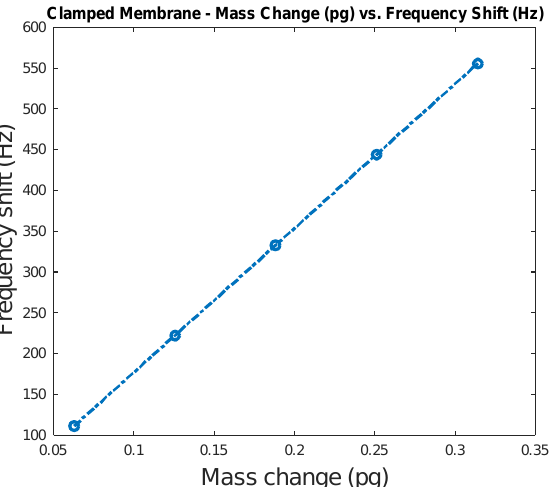
Figure 19. Sensitivity analysis for a silicon capacitive clamped membrane sensor when the target adsorbed mass is increased from 0.25 to 0.63 pg with a step size of 0.063 pg. The investigated sensor has a 40 μm diameter, when the thickness of the top and bottom membranes and the cavity height are 0.5 μm each. A bias of 20 V DC, which is chosen close to the device’s pull-in voltage, is applied to the capacitive clamped membrane mass sensor.